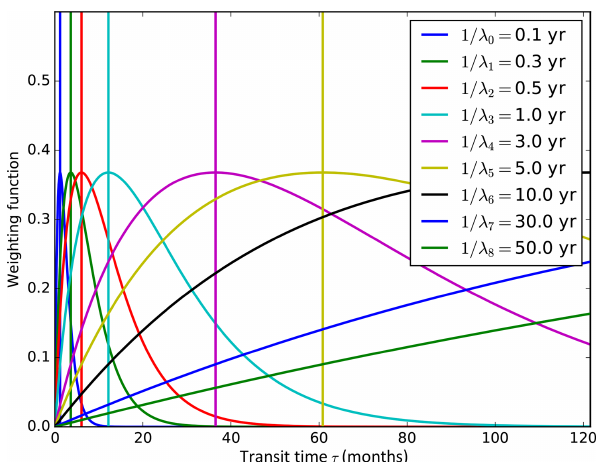
Figure 8. Shape of the weighting function to the age spectrum λ k t e − λ k t for radioactive or chemical product tracers with lifetimes 1 /λ k equal to that of the parent species. The vertical lines show the location of the maxima of the weighting functions, reached at transit times τ = 1 λ k